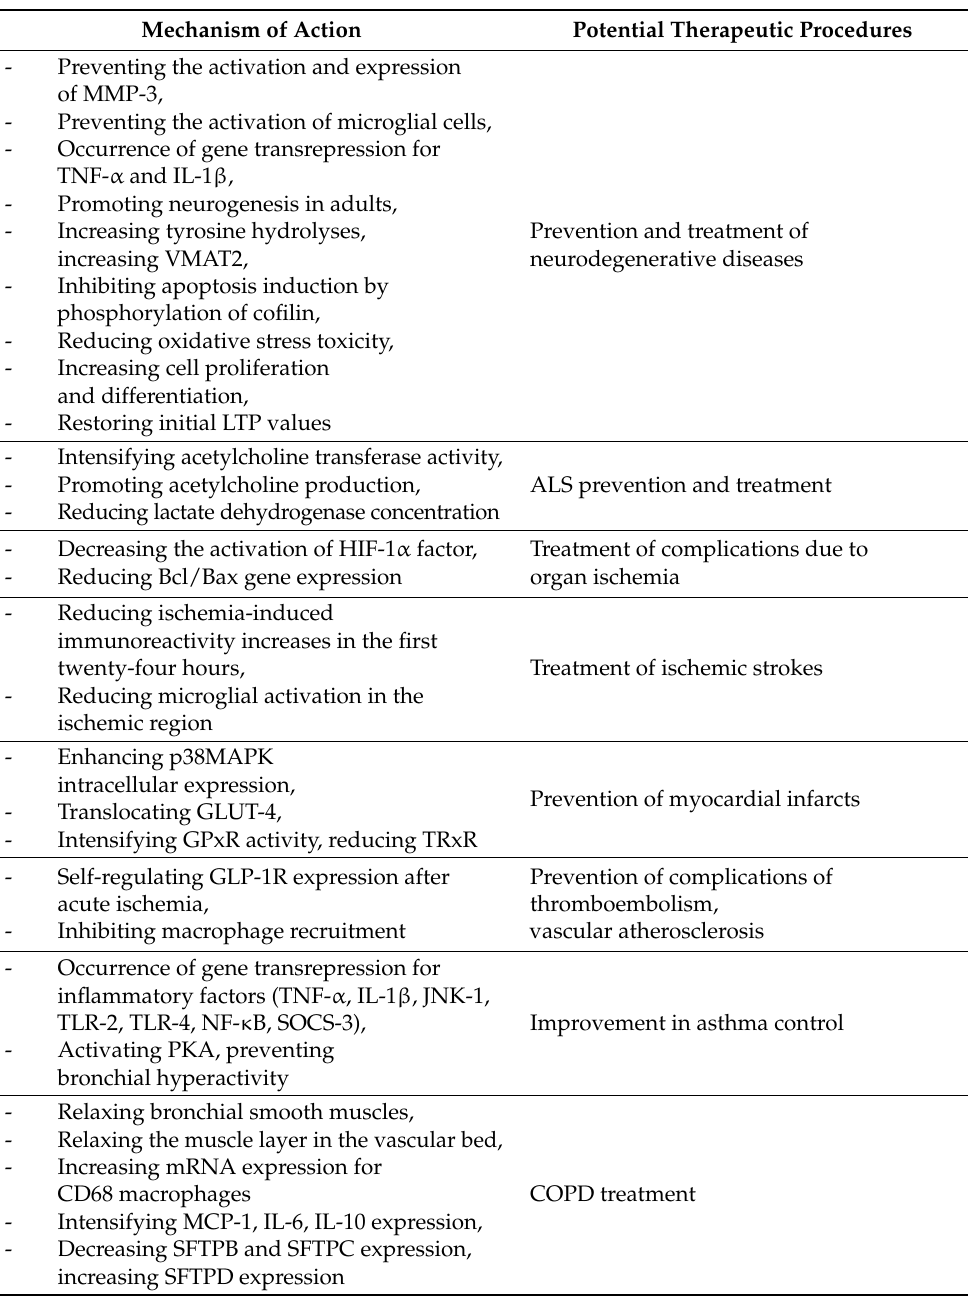
Table 3. Summary of the presented mechanisms. Mechanism of Action Potential Therapeutic